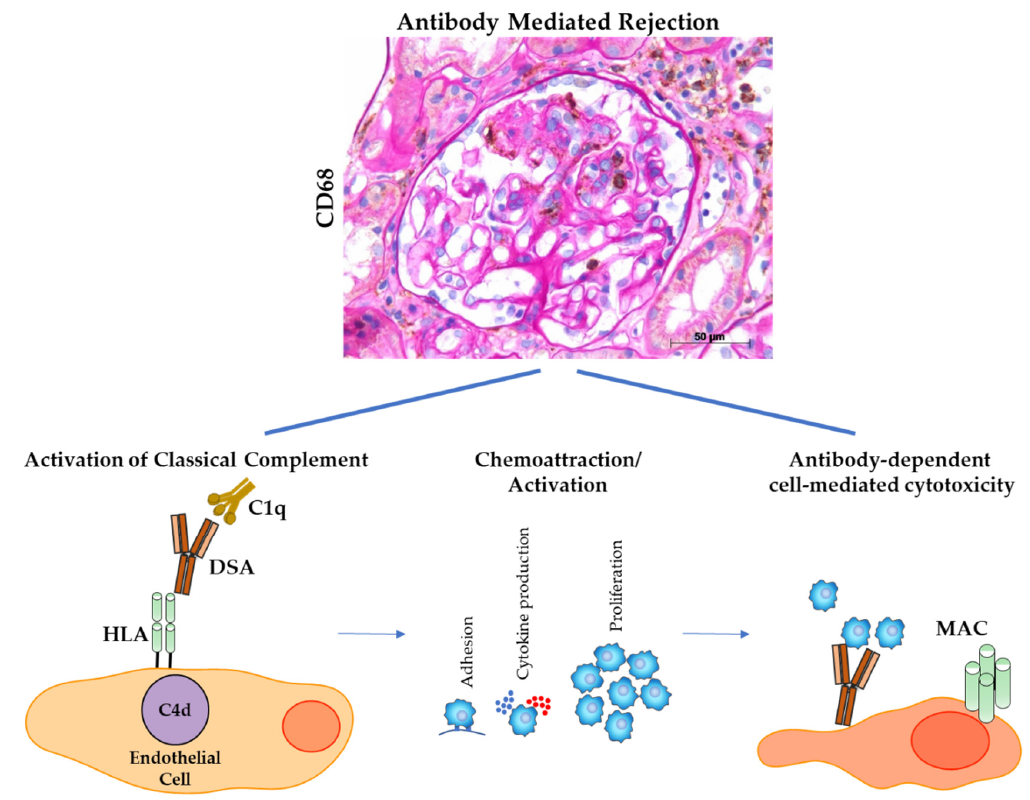
Figure 3. Representative image of C4d+ glomerulus of renal transplant and schematic representation of potential combined role of complement and M ϕ s in worsen renal lesions in Antibody Mediated Rejection. Histological image labeled for CD68 (macrophages, brown) and counterstained with periodic acid-Schiff (PAS) staining (bar = 50µM).